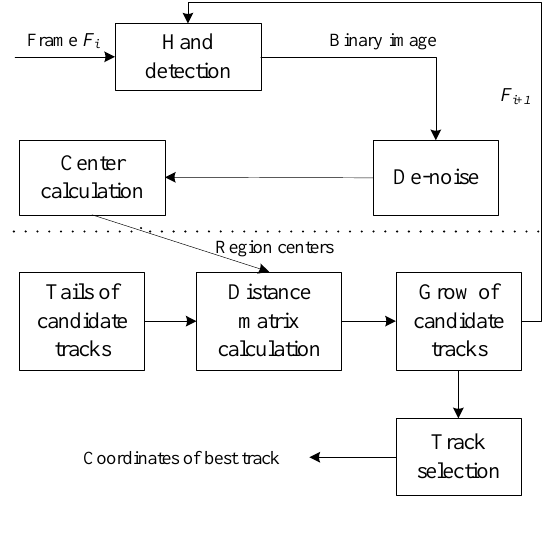
Figure 3. Workflow of gesture